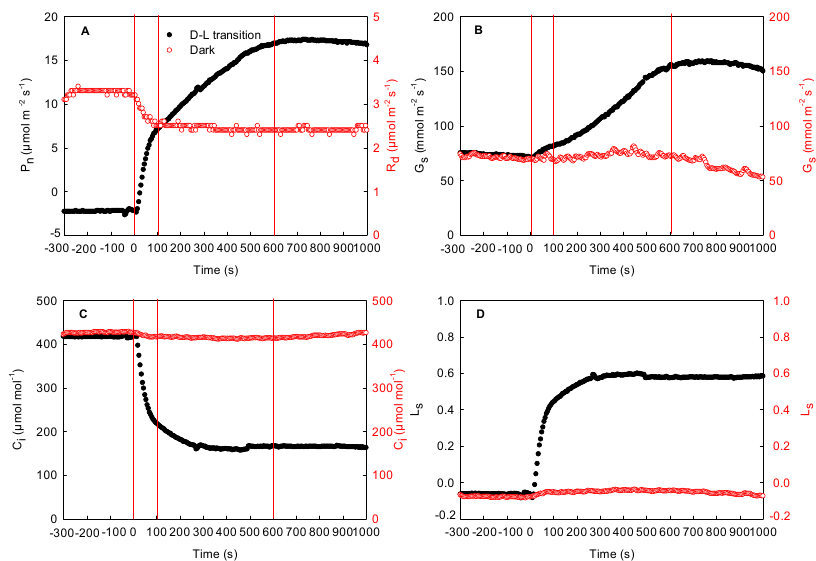
Figure 4. Effect of local illumination on the respiration rate of the adjacent region in the same cotton leaves. ( A ) photosynthetic induction under the dark–light transition in the local regions or respiration in darkness in the adjacent region; ( B ) stomatal conductance under the dark–light transition in the local regions or under the darkness in the adjacent region; ( C ) intercellular CO 2 concentration under the dark–light transition in the local regions or under the darkness in the adjacent region; ( D ) stomatal limitation under the dark–light transition in the local regions or in darkness in the adjacent region. C i , intercellular CO 2 concentration; D–L transition, dark–light transition; G s , stomatal conductance; L s , stomatal limitation; P n , photosynthetic rate; R d , respiration in darkness.